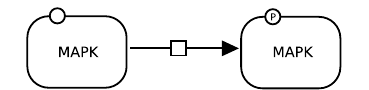
Figure 2.26: Phosphorylation of the protein MAP kinase.